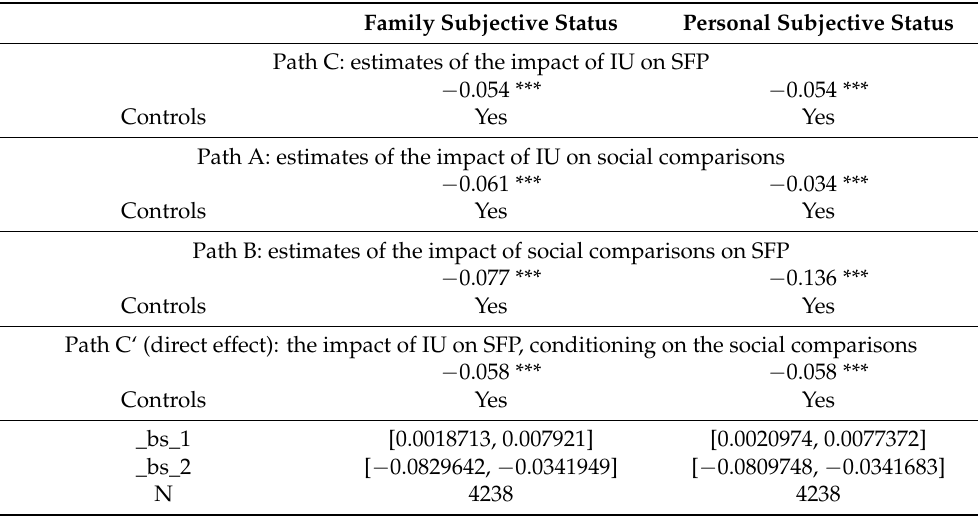
Table 5. Analysis of the role path of social comparison.